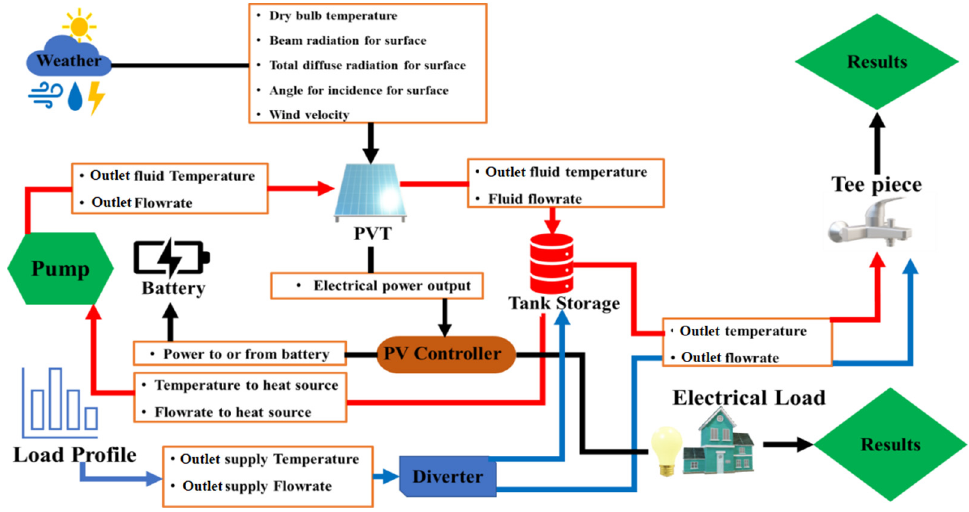
Figure 1. Schematic diagram of the PVT system.